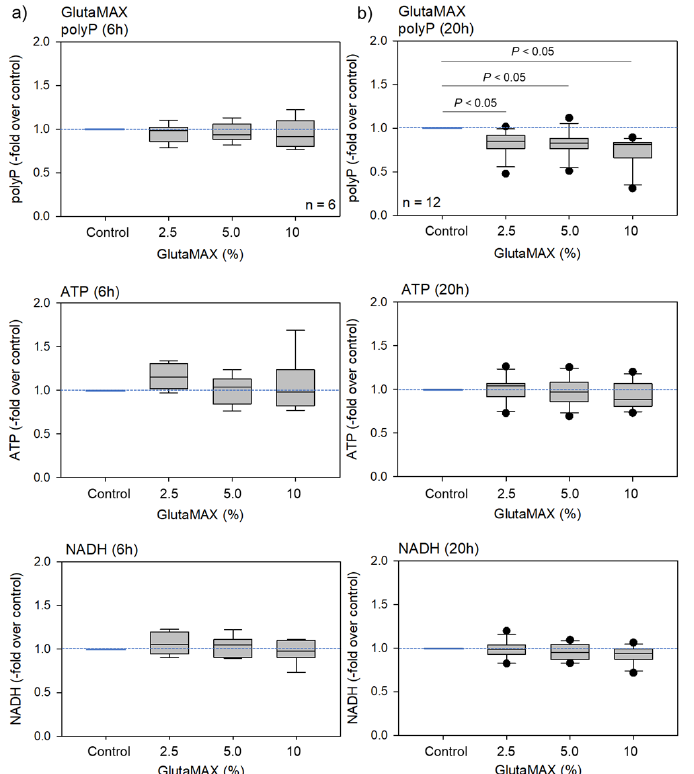
Figure 5. The effects of GlutaMAX on platelet polyP, ATP, and NADH levels after 6 h ( a ) or 20 h ( b ) of treatment. Statistical analysis was performed using a non-parametric test. n = 6 ( a ) or 12 ( b ).